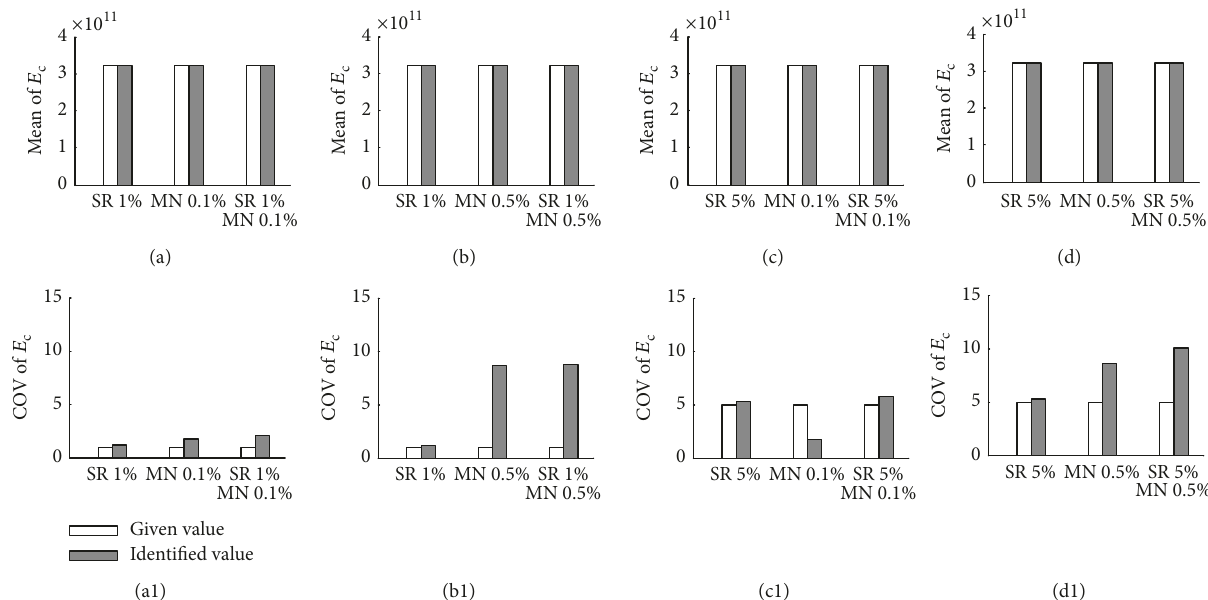
Figure 7: Means and COVs of elastic moduli of ceramics ( 𝐸 c ) for FGM along axial direction with different